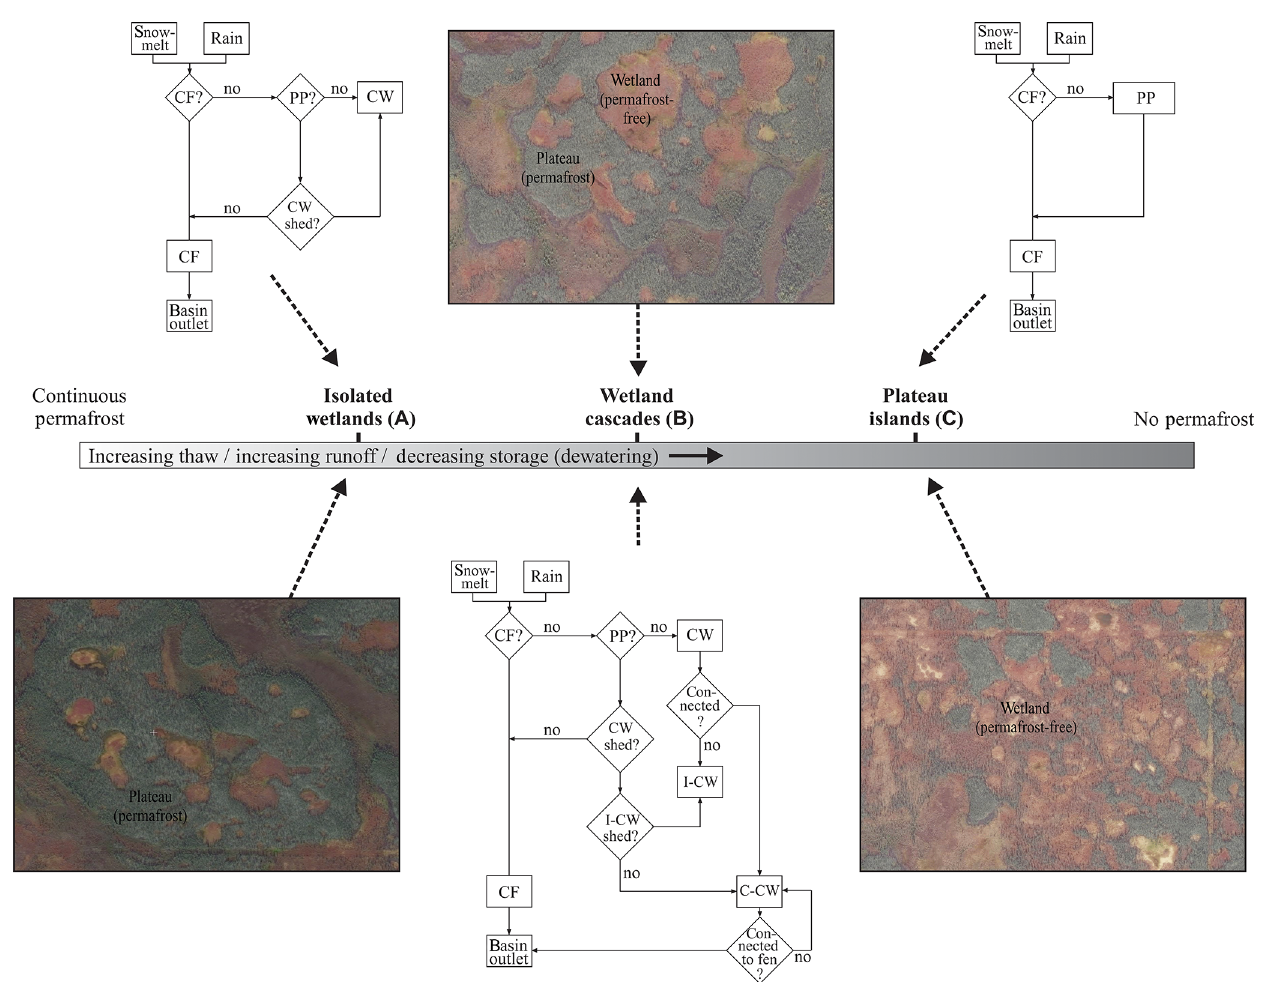
Figure 12. The transformation of peat plateau runoff generation processes with increasing thaw from left to right. PP: peat plateau, CF: channel fen, CW: collapsed wetland, I: isolated, C: connected. The term “shed” refers to the watershed of a land cover feature. For example, “CW shed” refers to the water shed of a collapsed wetland. Modified from Quinton et al.